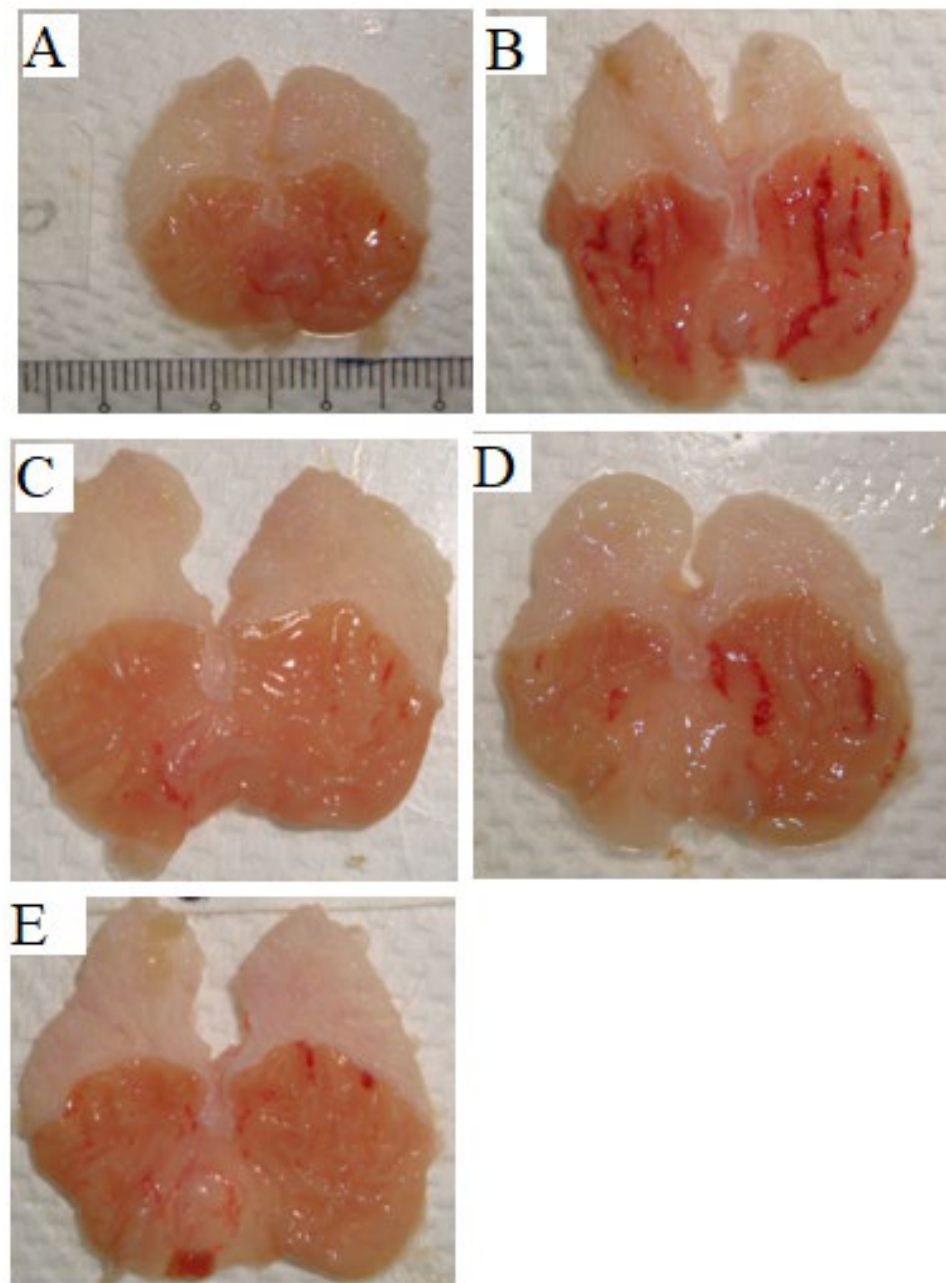
Figure 3. Effects of p -Cymene on the macroscopic appearance of gastric mucosa in ethanol-induced gastric mucosal damage in rats. The normal control group ( A ); the ulcer control group ( B ); the reference group (omeprazole, 20 mg/kg) ( C ); rats that receive 30 mg/kg of p -Cymene ( D ); and rats that received 60 mg/kg of p -Cymene ( E ).